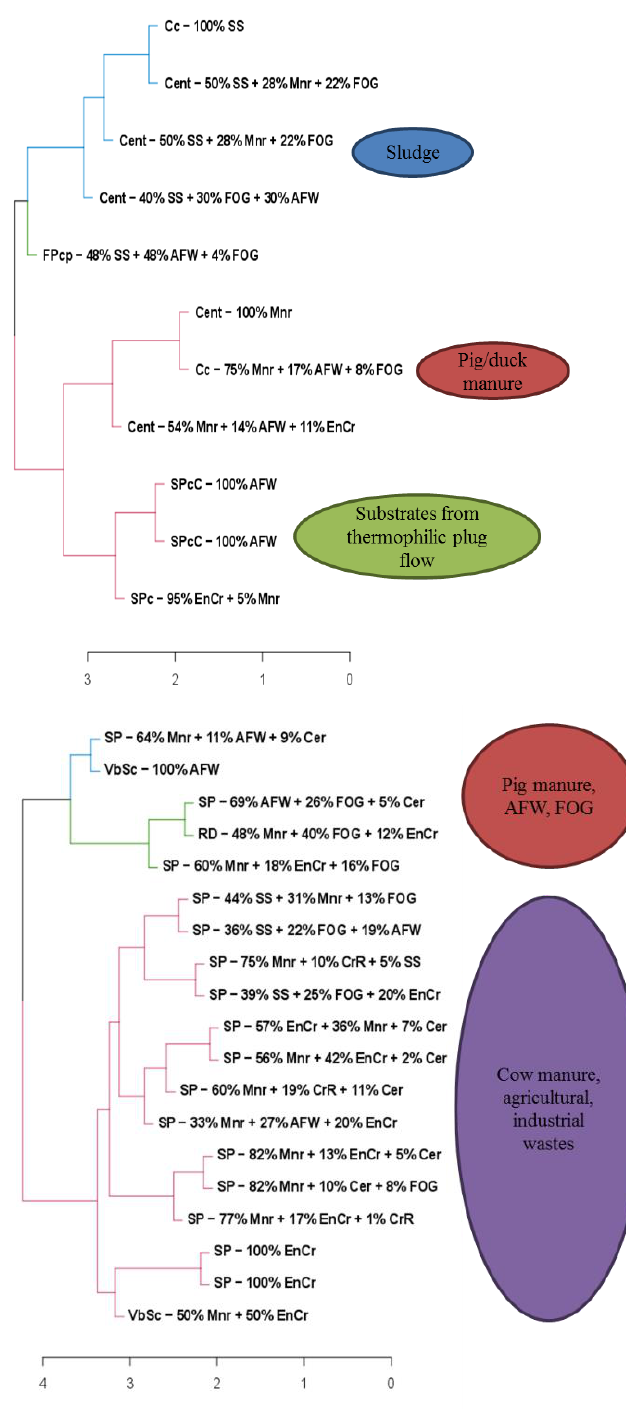
Figure 4. Clustering of feedstocks (Left: High performance solid–liquid-solid separation, Right: Low performance solid–liquid